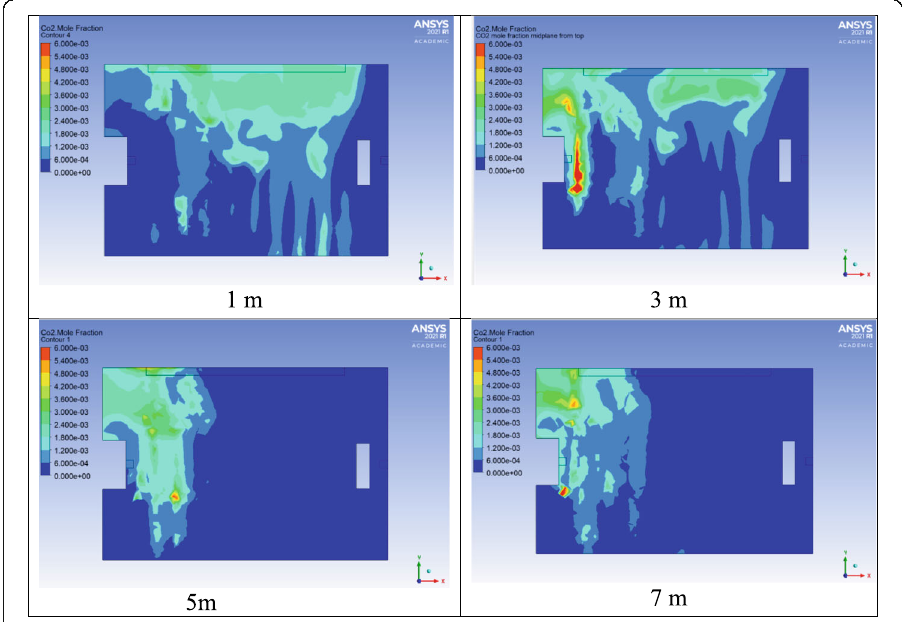
Fig. 20 Contours of CO 2 concentration (ppm) at different heights of the chimney at the breathing level of students 1.20 m, output from the ANSYS CFD model